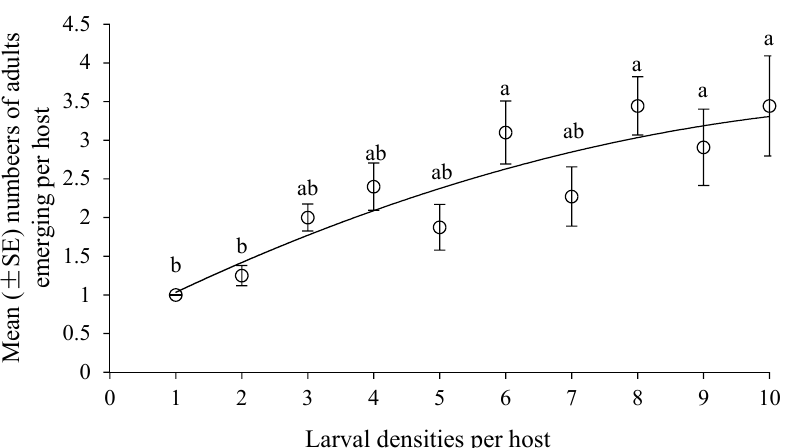
Figure 1. Mean (± SE) numbers of adults emerging per host with various larval densities (regression: y = − 0.0166 x 2 + 0.435 x + 0.6155; adjusted r ² = 0.8127, p = 0.0001). The different letters above each larval density show significant difference among treatments at a = 0.05.